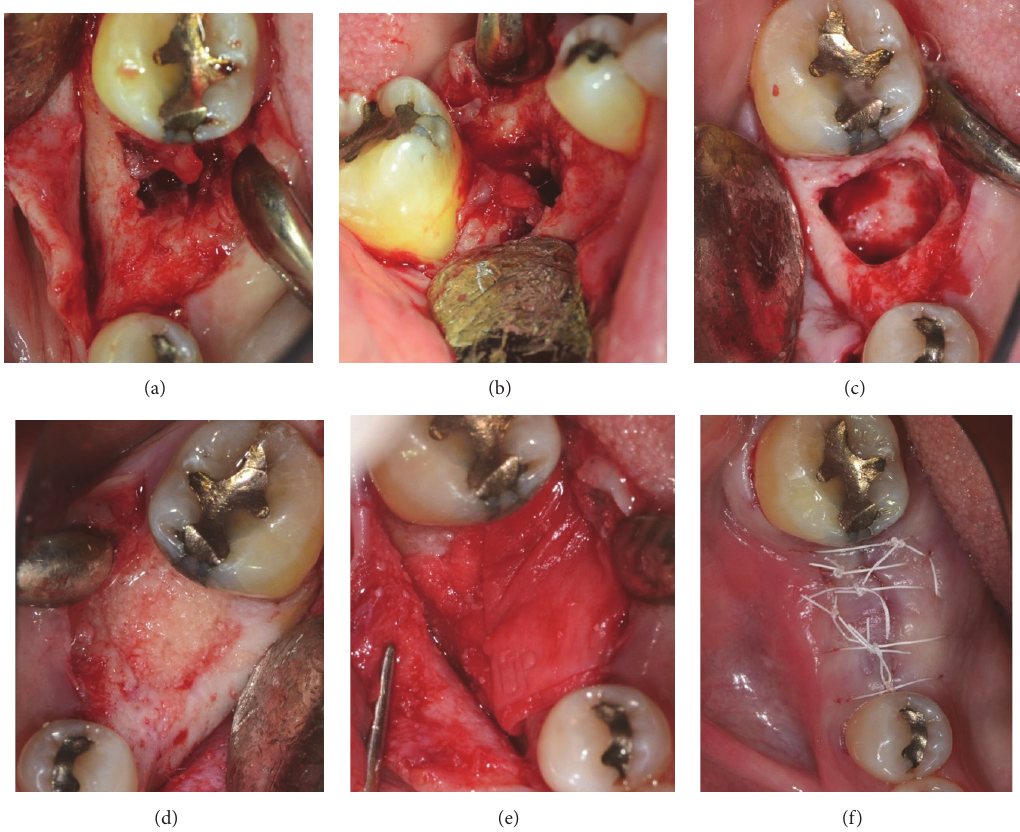
Figure 3: Guided bone regeneration procedure was performed on the erratic extraction site (a–f). After a full-thickness flap was elevated, granulation tissue was noted filling the previously extracted site (a and b). Following thorough debridement and irrigation, the site was determined to be a containable defect (c). FDBA was gently packed in the socket and covered with non-cross-linked collagen membrane (d and e). Complete primary closure was achieved with a combination of horizontal mattress and single interrupted sutures